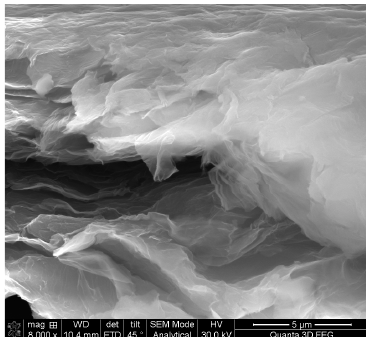
Figure 2. SEM image of the edge of a self-assembled GO film showing the wrinkled nanosheets at the edge of the microstructure.